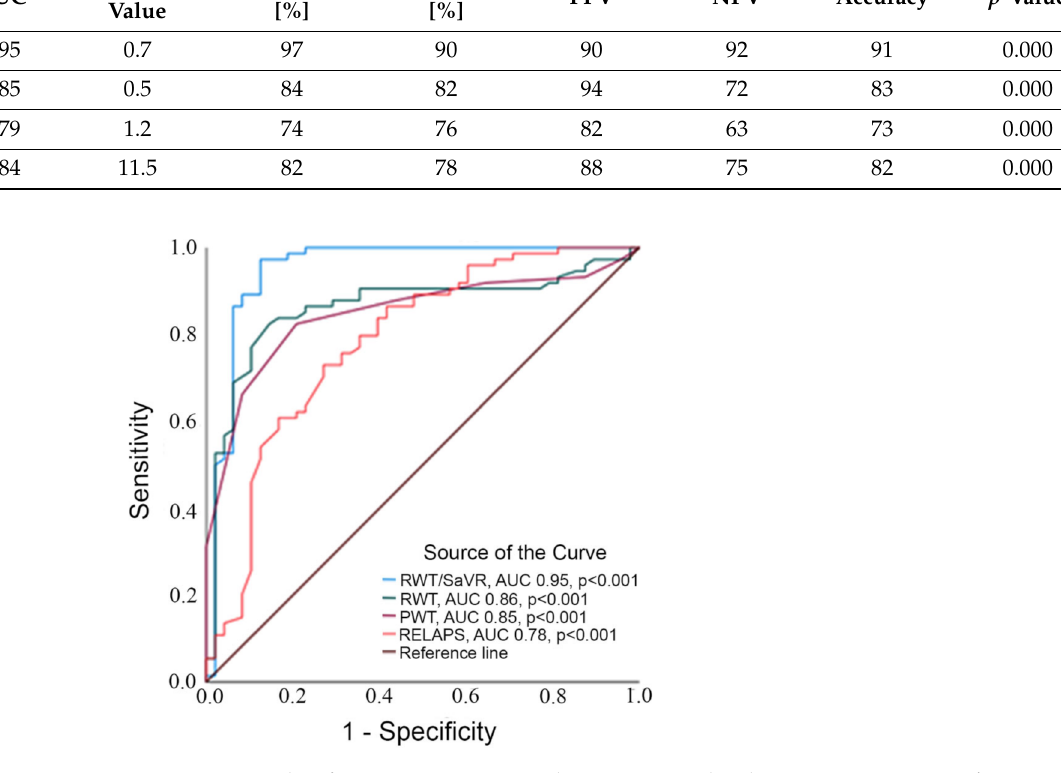
Figure 1. Legend to figure: ROC curve analyzing area under the curve testing RWT/SaVR, RWT, PWT and